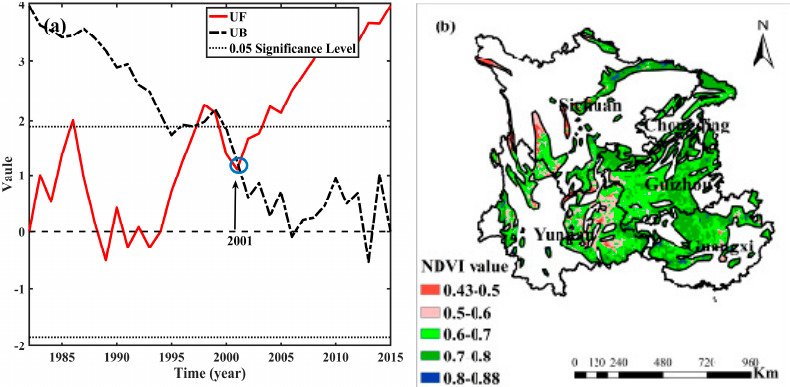
Figure 3. The breakpoint and the spatial distribution of growing-season NDVI in the karst region of southwest China; ( a ) the abrupt change of NDVI, ( b ) the spatial distribution of mean NDVI from 1982 to 2015. Remote Sens. 2019 , 11 FOR PEER REVIEW